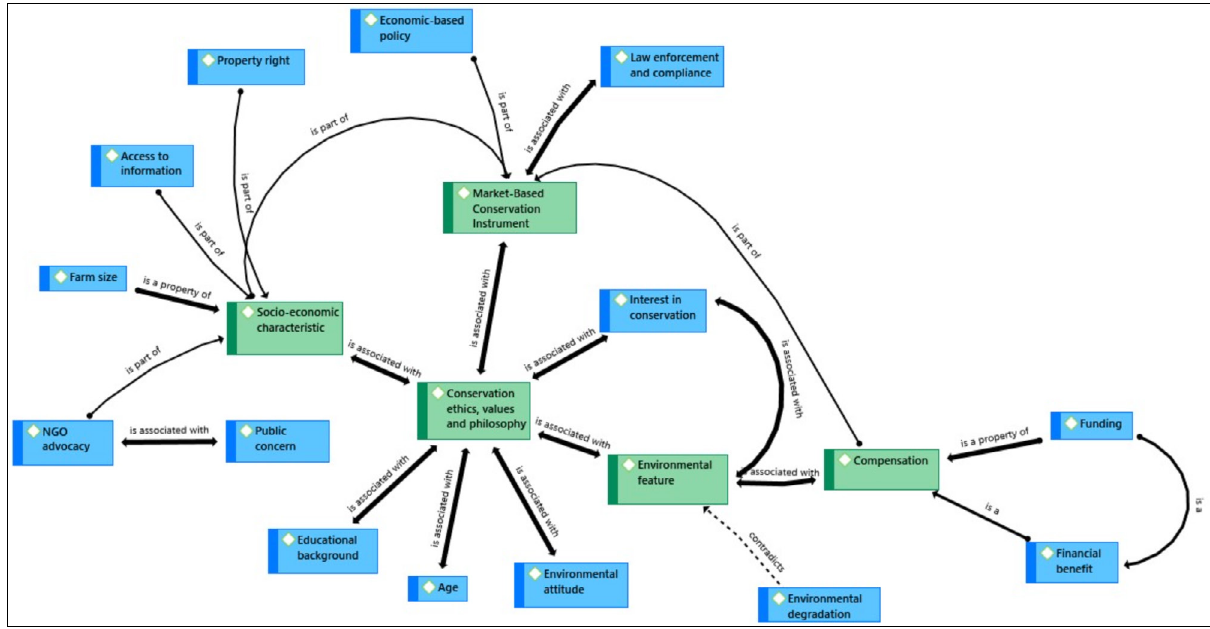
A cognitive map from the review of determinants of willingness to invest in ecological infrastructure by private landowners and other